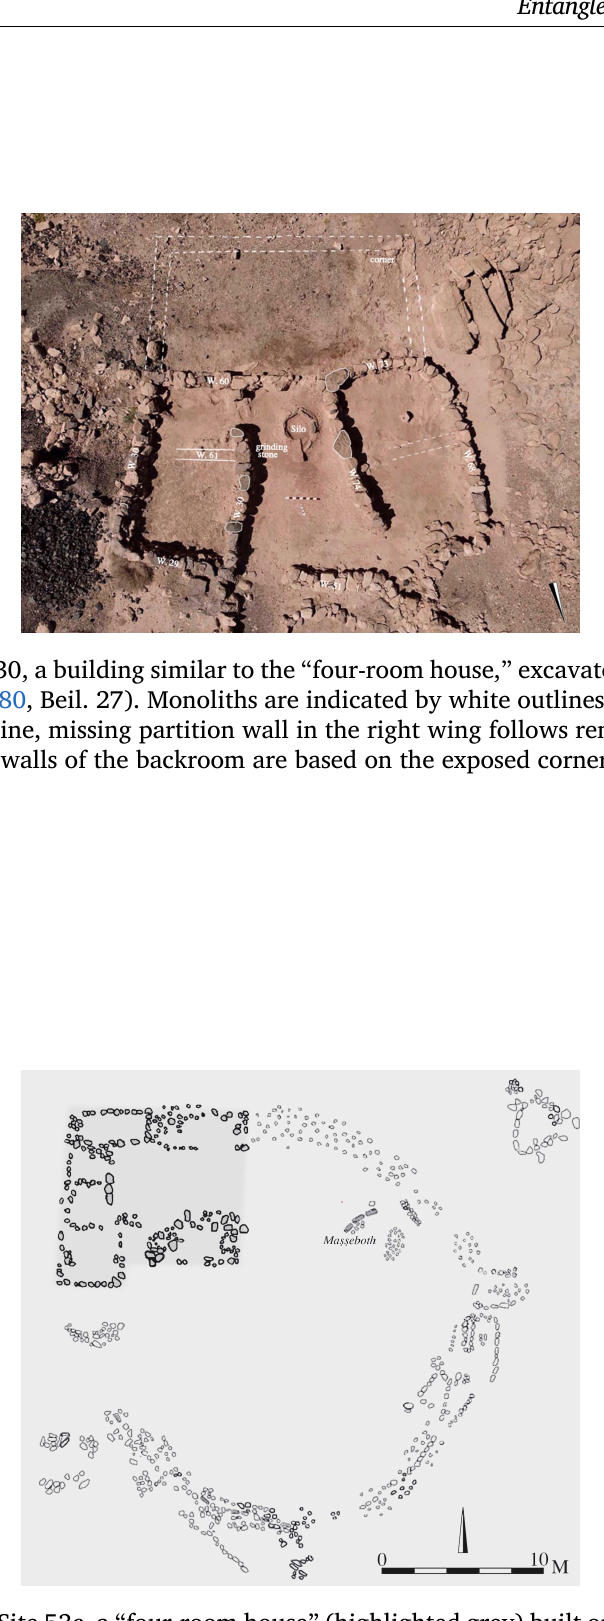
Figure 8 ‘Uvda Vally Site 53c, a “four-room house” (highlighted grey) built on top of large courtyard of the fifth to third millennia